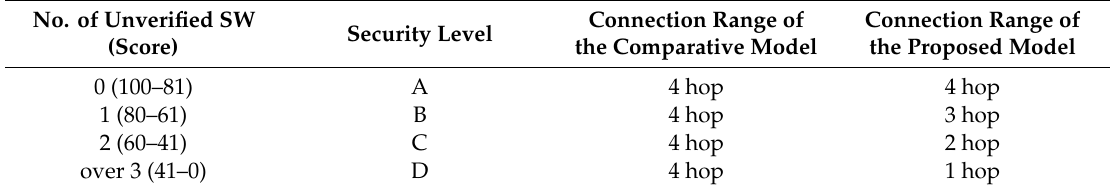
Table 2. Evaluation